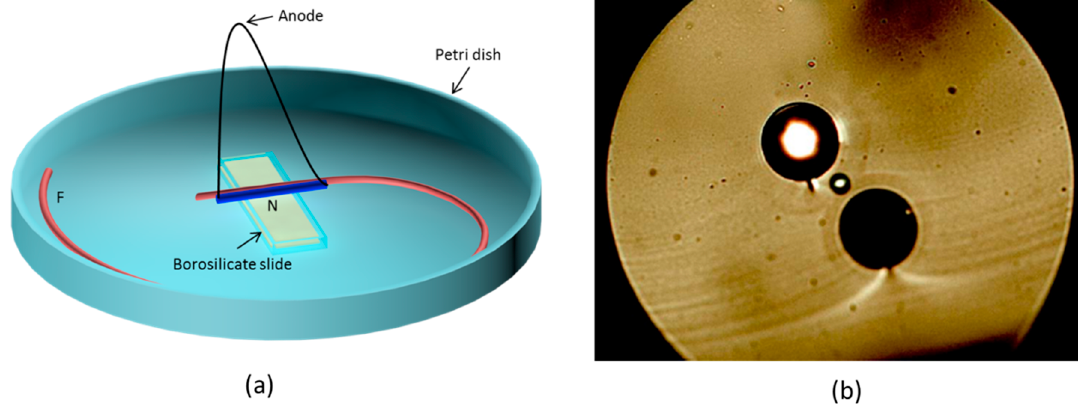
Figure 3 : ( a ) Schematic of the setup to pole twin-hole silica fibers via electrostatic induction. The inductor is represented by the blue fiber. Two metallic wires are inserted in the two cladding holes and connected to the identical anodic potential. This fiber is basically used as a layer of dielectric material simply to avoid unwanted electrical arcing discharge in air. The fiber represented in red (whose embedded electrodes are left floating) represents the fiber to be poled. Inductor and sample are attached to a microscope slide by means of some Kapton tape and maintained adjacent along 2.5